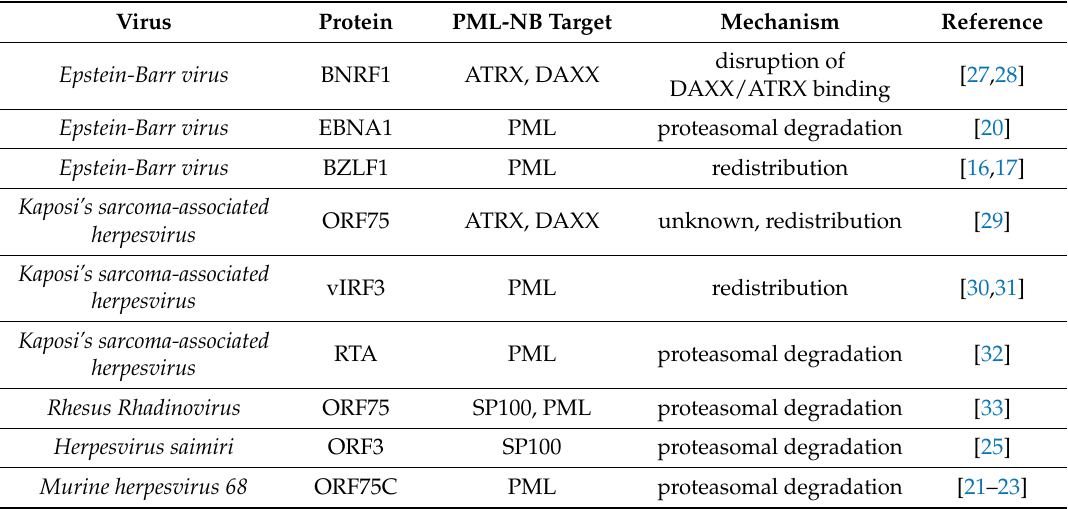
Epstein-Barr virus BZLF1 PML herpesvirus